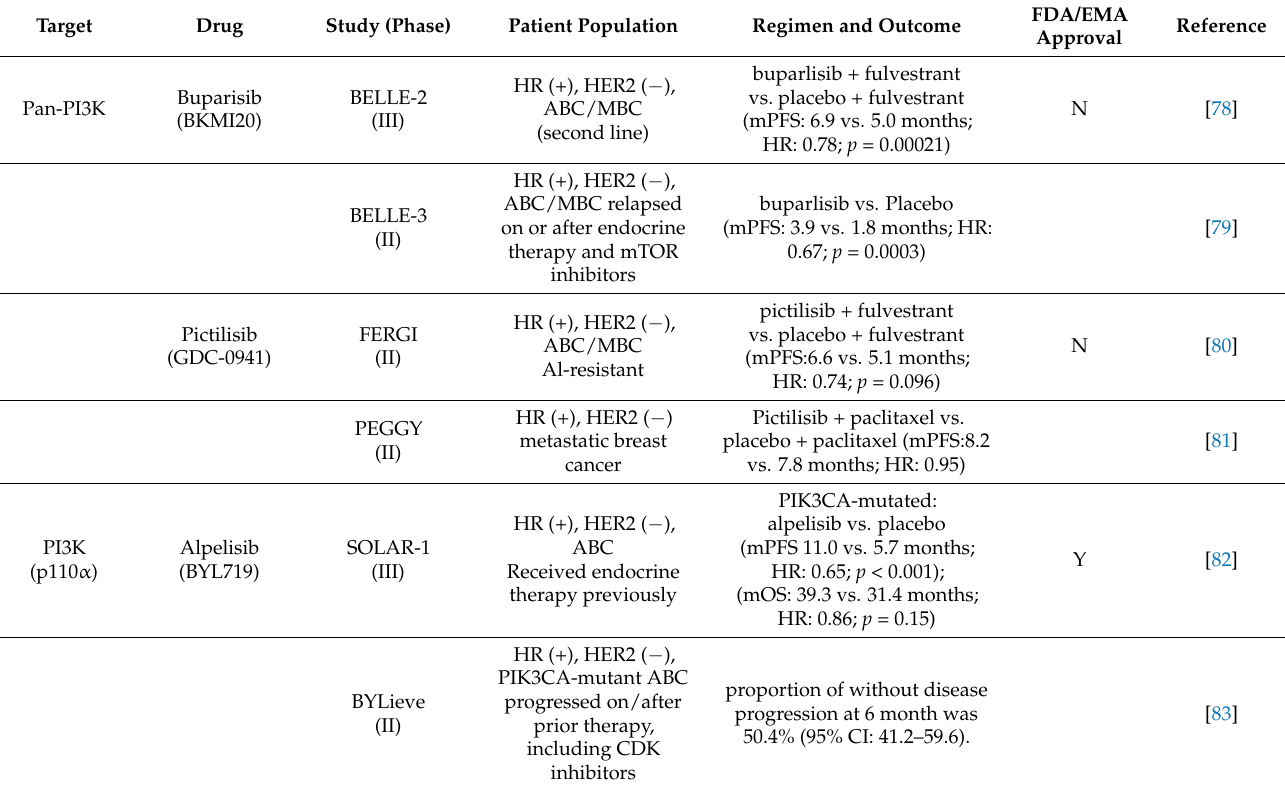
Table 2. Clinical trials of PI3K inhibitors in ER+/HER2 − breast